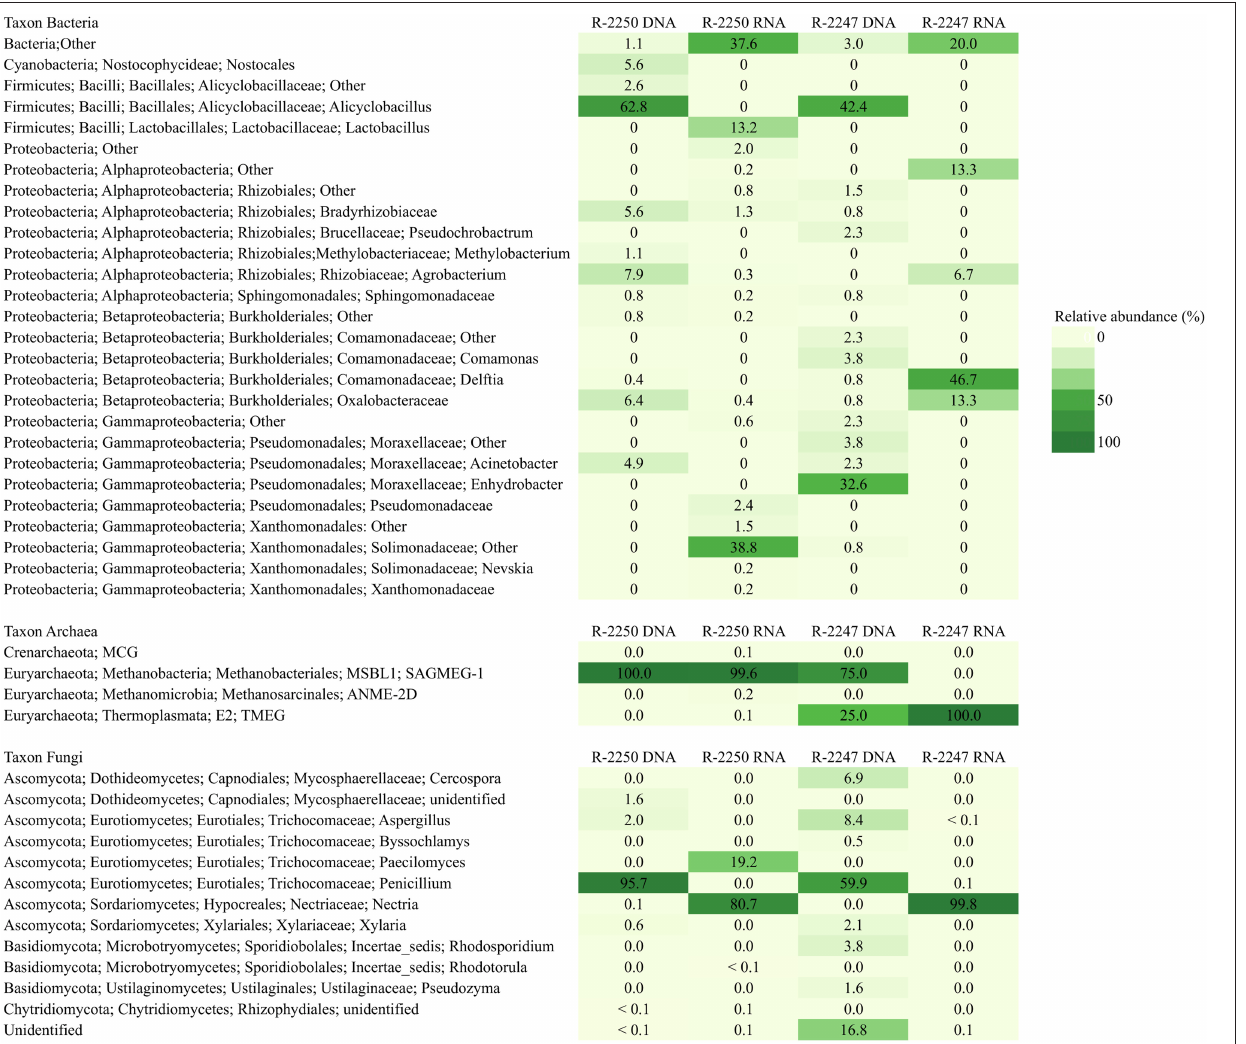
FIGURE 5 | Bacterial, archaeal, and fungal taxonomy in deep groundwaters of the Pyhäsalmi mine in drill holes R-2247 and R-2250. Taxonomic classification of the bacterial, archaeal, and fungal sequence reads obtained by high throughput sequencing of the total (DNA) and potentially active (RNA) communities presented at the genus